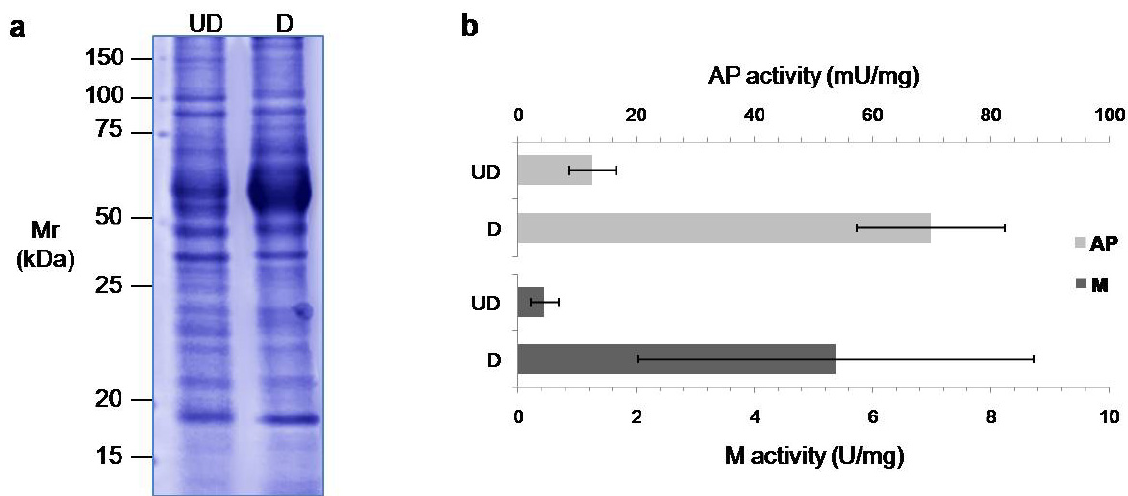
Figure 1. ( a ) Monodimensional protein pattern detected by Coomassie staining of the secretome of undifferentiated (UD, left) and differentiated (D, right) Caco-2 cells; Mr: relative molecular mass; ( b ) Specific activity of the enzymes alkaline phosphatase (AP, clear bars) and maltase (M, dark bars), known markers of enterocytic